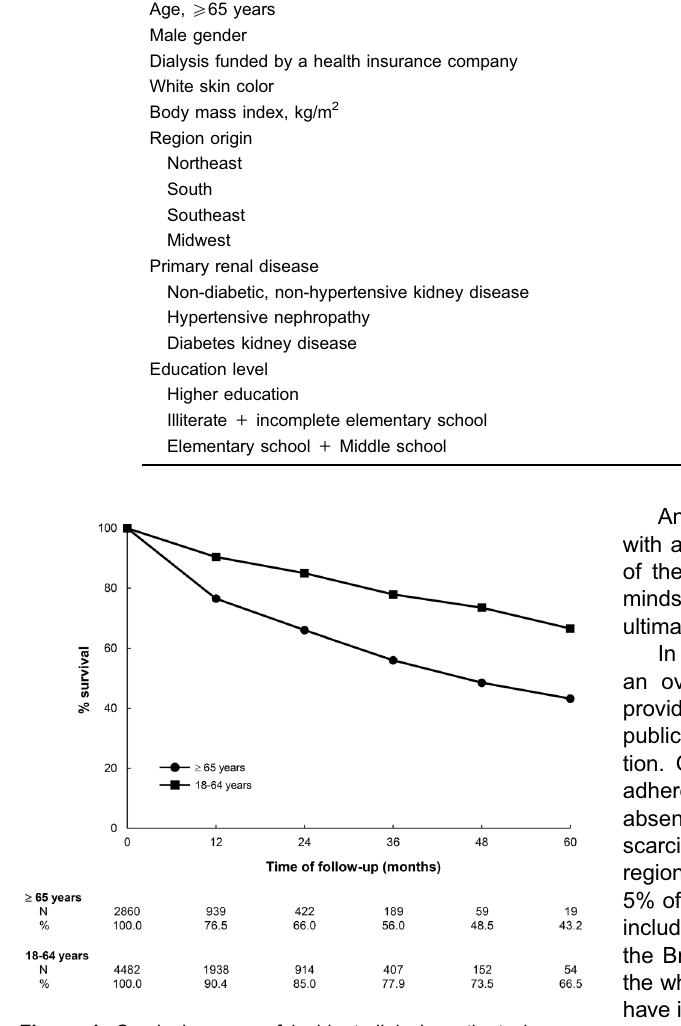
Figure 1. Survival curves of incident dialysis patients by age group. P o 0.001, comparison between the